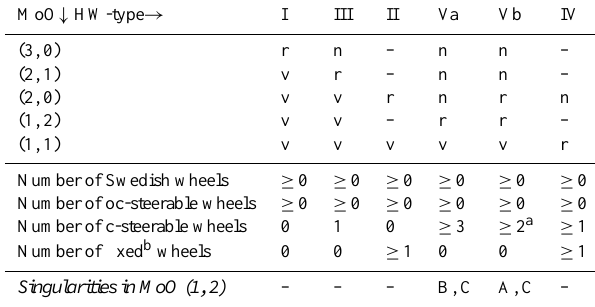
Table 1. How inv( (cid:49) ) spans T G . Vector fields and Lie brackets that span T G are underlined.